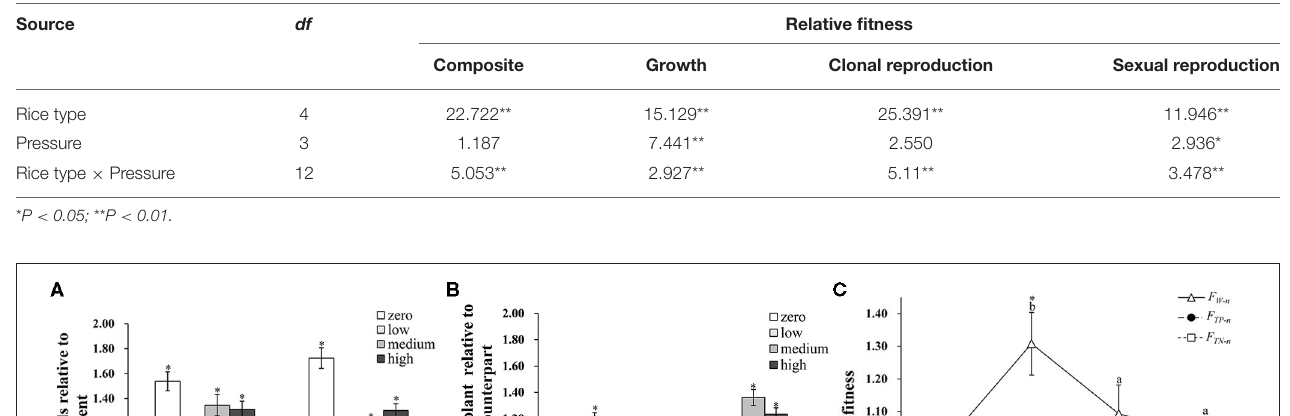
KF8 population, several fitness estimates ( F KF 8 − n ) were >